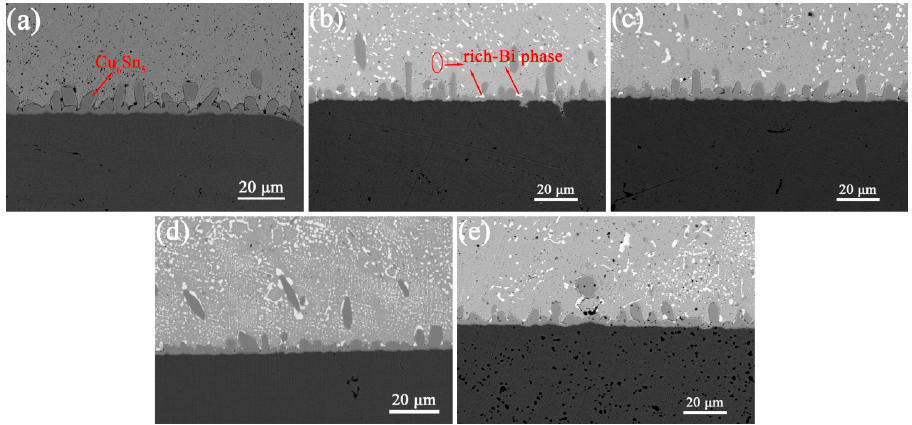
Figure 4. The cross-sectional image of ( a ) Sn-0.7Cu, the cross-sectional image of Sn-0.7Cu-10Bi-xCr: ( b ) 0.05 wt.%, ( c ) 0.1 wt.%, ( d ) 0.2 wt.% and ( e ) 0.3 wt.%.